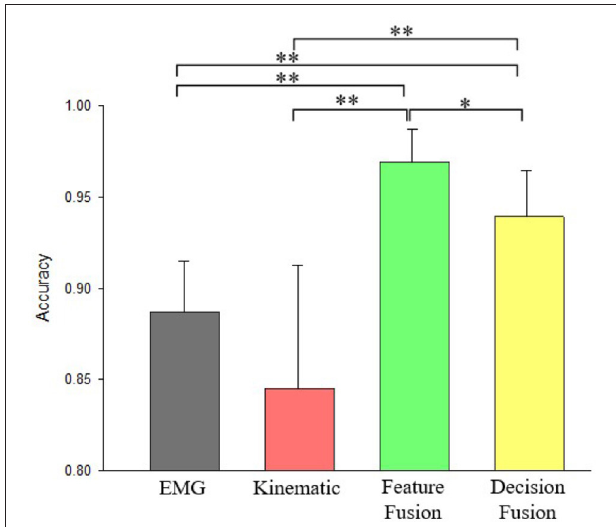
FIGURE 6 | Accuracy comparisons of pattern recognition using EMG only, kinematics only, feature fusion of kinematics + EMG, and decision fusion of kinematics + EMG for normal subjects. * Denotes p < 0.05, ** Denotes p < 0.01.